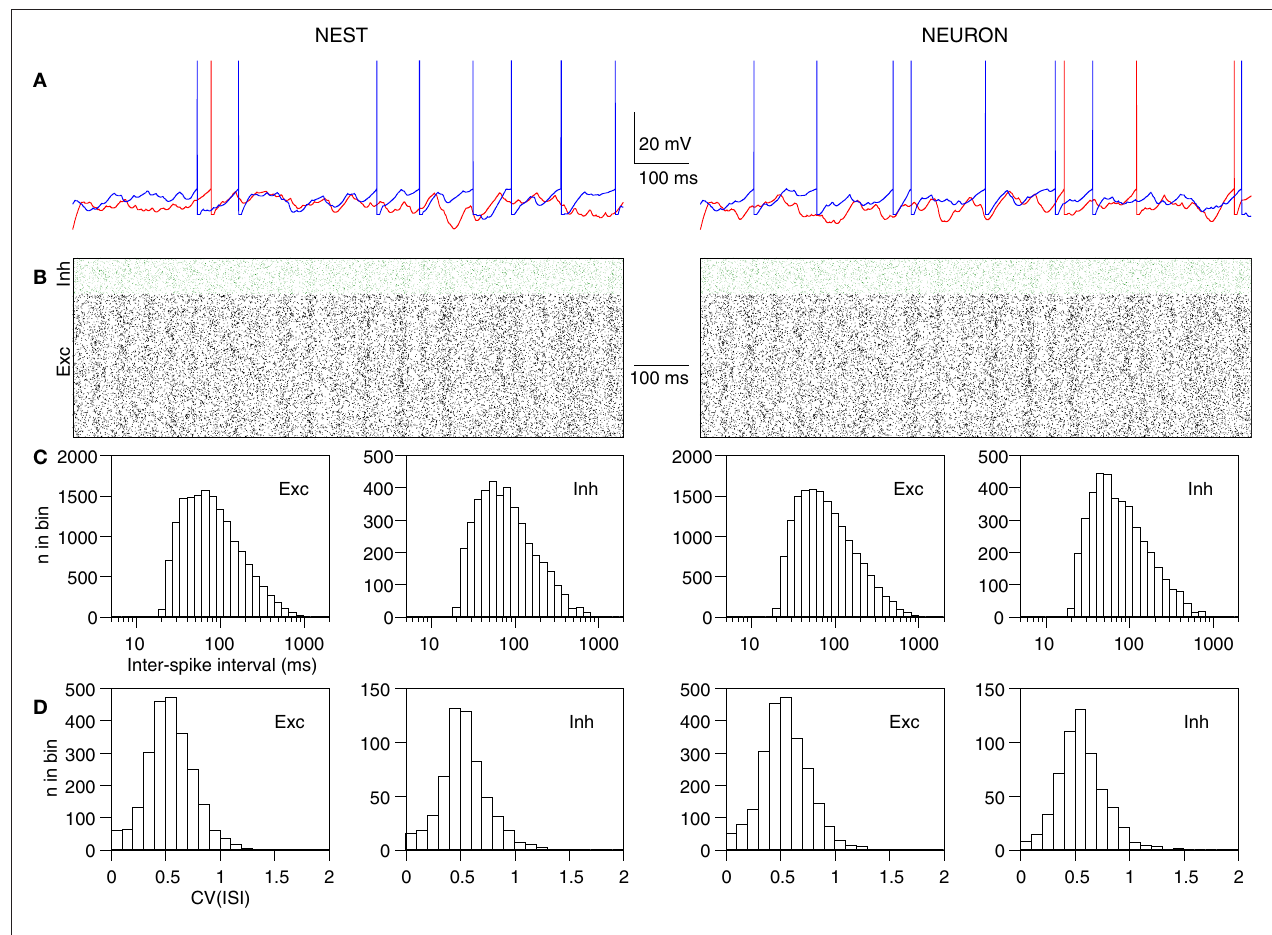
FIGURE 2 | Results of running the second example given in the text, with NEURON and NEST as back-end simulators. Note that the network connectivity and initial conditions were identical in the two cases. (A) Membrane potential traces for two excitatory neurons. Note that the NEST and NEURON traces are very similar for the fi rst 50 ms, but after that diverge rapidly due to the effects of network activity, which amplifi es the